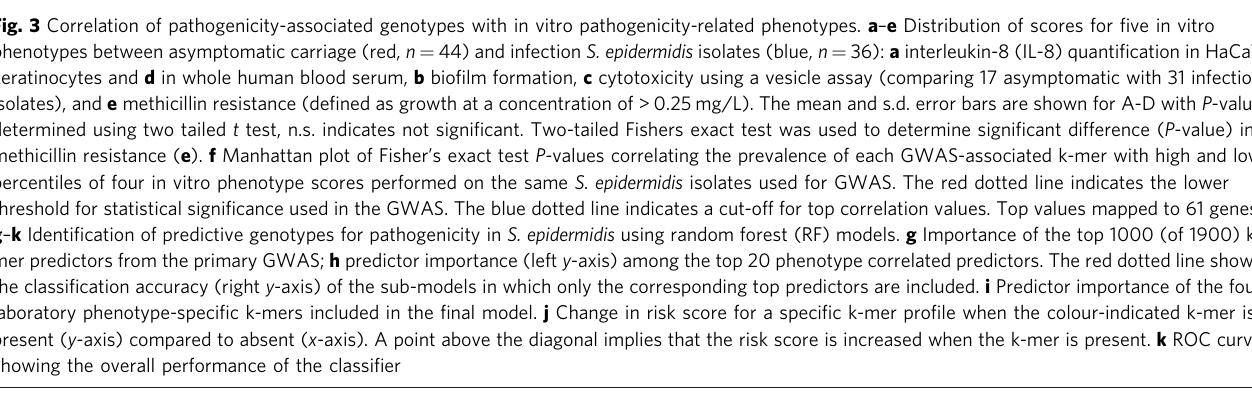
Fig. 3 Correlation of pathogenicity-associated genotypes with in vitro pathogenicity-related phenotypes. a – e Distribution of scores for fi ve in vitro phenotypes between asymptomatic carriage (red, n = 44) and infection S. epidermidis isolates (blue, n = 36): a interleukin-8 (IL-8) quanti fi cation in HaCaT keratinocytes and d in whole human blood serum, b bio fi lm formation, c cytotoxicity using a vesicle assay (comparing 17 asymptomatic with 31 infection isolates), and e methicillin resistance (de fi ned as growth at a concentration of > 0.25 mg/L). The mean and s.d. error bars are shown for A-D with P -value determined using two tailed t test, n.s. indicates not signi fi cant. Two-tailed Fishers exact test was used to determine signi fi cant difference ( P -value) in methicillin resistance ( e ). f Manhattan plot of Fisher ’ s exact test P -values correlating the prevalence of each GWAS-associated k-mer with high and low percentiles of four in vitro phenotype scores performed on the same S. epidermidis isolates used for GWAS. The red dotted line indicates the lower threshold for statistical signi fi cance used in the GWAS. The blue dotted line indicates a cut-off for top correlation values. Top values mapped to 61 genes.